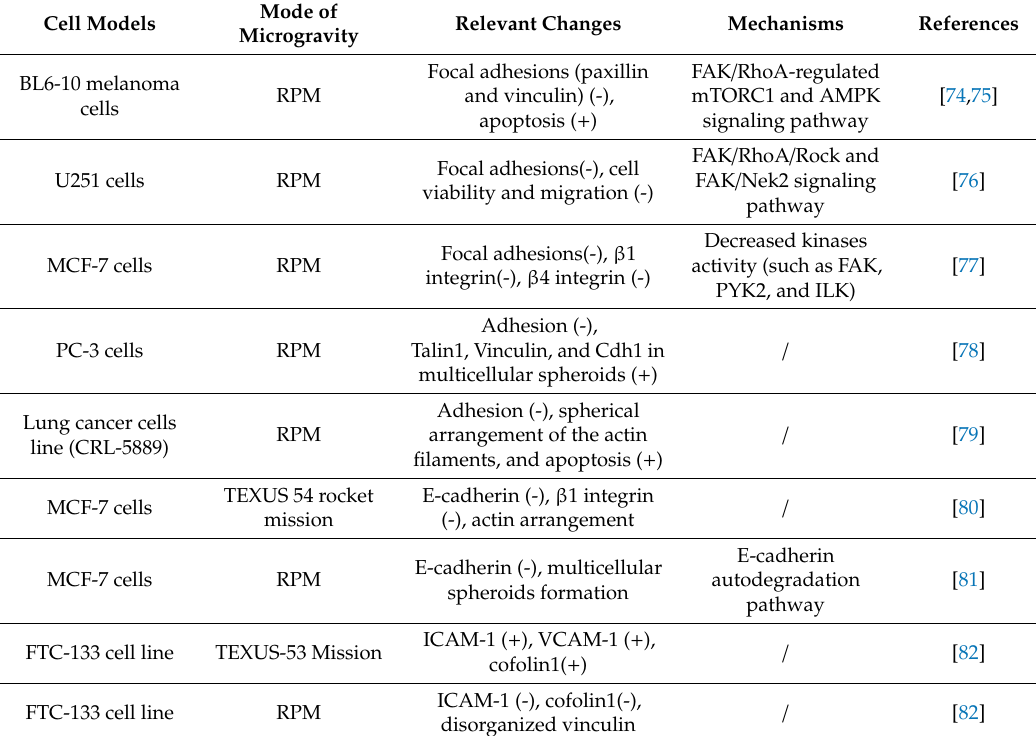
Table 4. E ff ects of microgravity on tumor cells